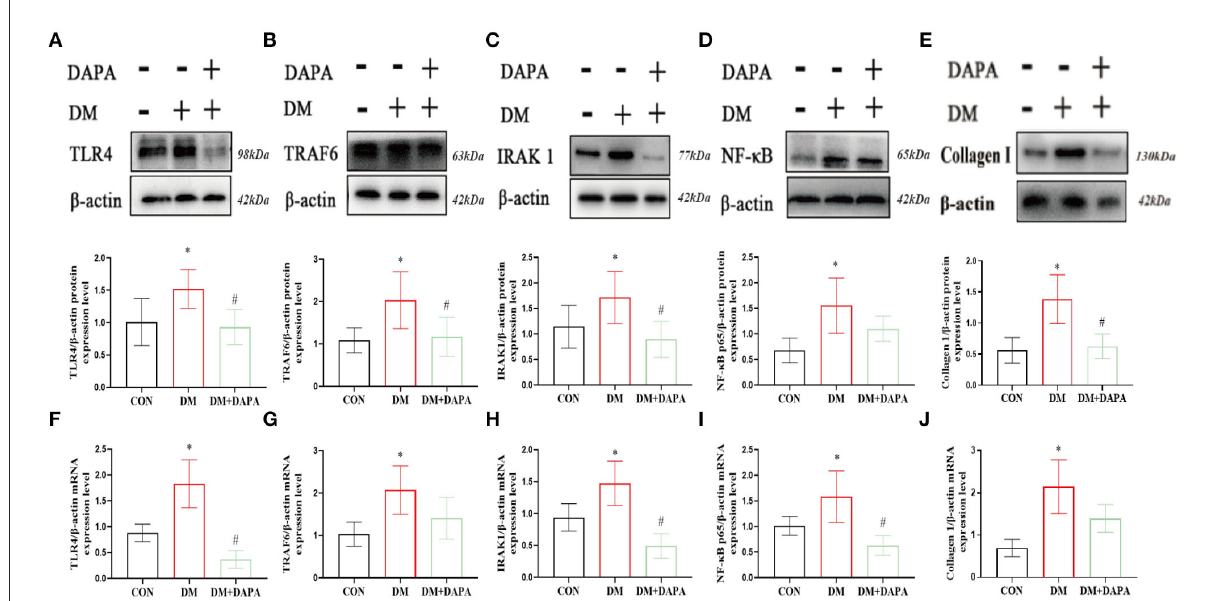
FIGURE5 DAPA inhibits TLR4/IRAK1/TRAF6/NF- κ B inflammatory pathways and Collagen I in atrium. (A–E) Protein expression of TLR4, TRAF6, IRAK1, NF- κ B and Collagen I ( n = 5-8). (F–J) mRNA expression of TLR4, TRAF6, IRAK1, NF- κ B, and Collagen I ( n = 5). CON, control group; DM, diabetes group; DM + DAPA, diabetes + dapagliflozin group. Data are expressed as the mean ± SEM. * P < 0.05 vs. CON group. # P < 0.05 vs. DM group.